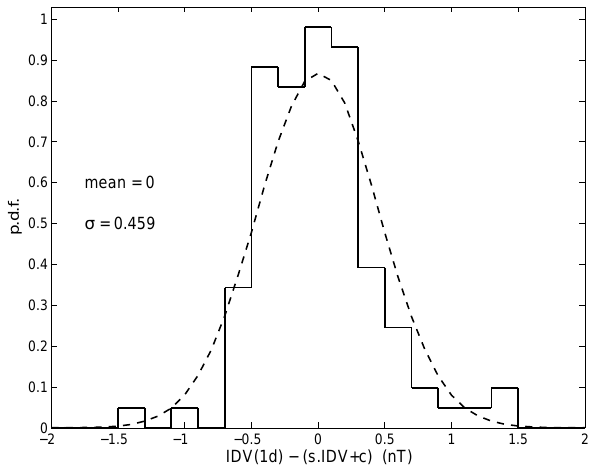
Fig. 4. The distribution of fit residuals IDV(1d) − ( s · IDV + c) where s and c are the best-fit linear regression coefficients derived from Fig. 12 in Part 1. The regression fit giving s and c is for 1880– 2012 whereas the above distribution is for 1966–2012. Neverthe- less, the mean of the distribution is 0nT to within 5 decimal places. The standard deviation is 0.459nT. The dashed line is the best-fit Gaussian distribution of the same mean and standard deviation.